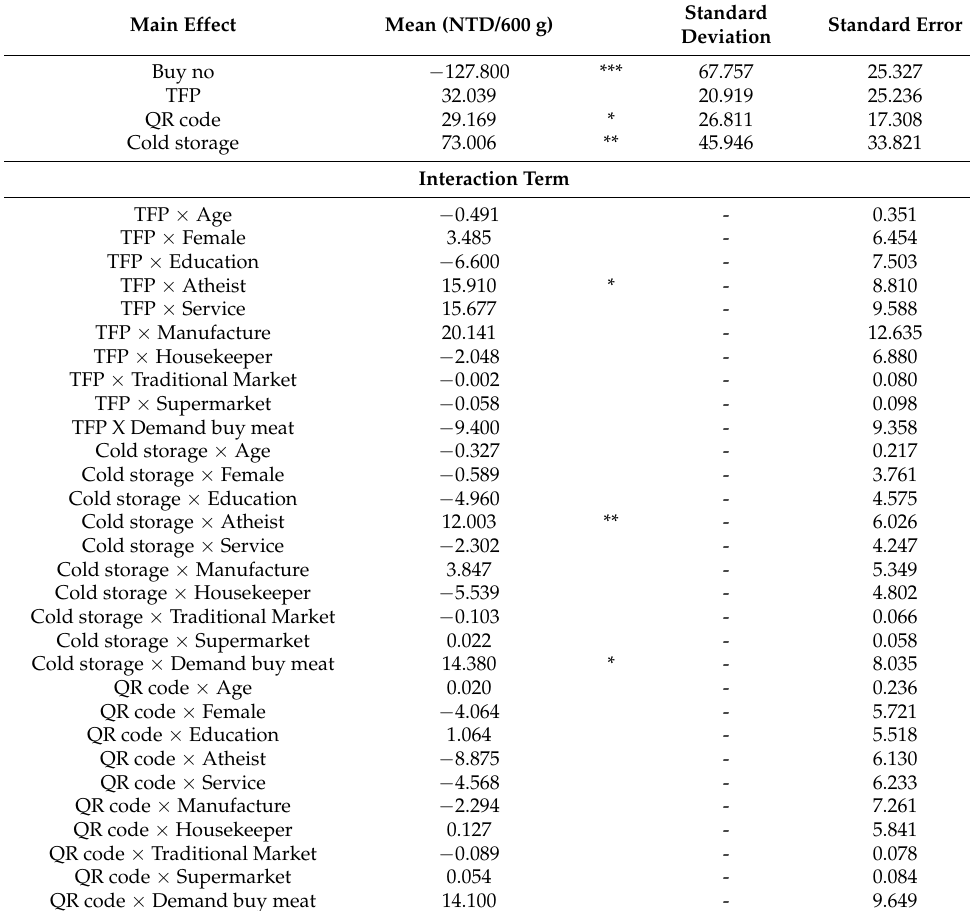
Table 5. Estimation of the mean willingness to pay (MWTP) using the